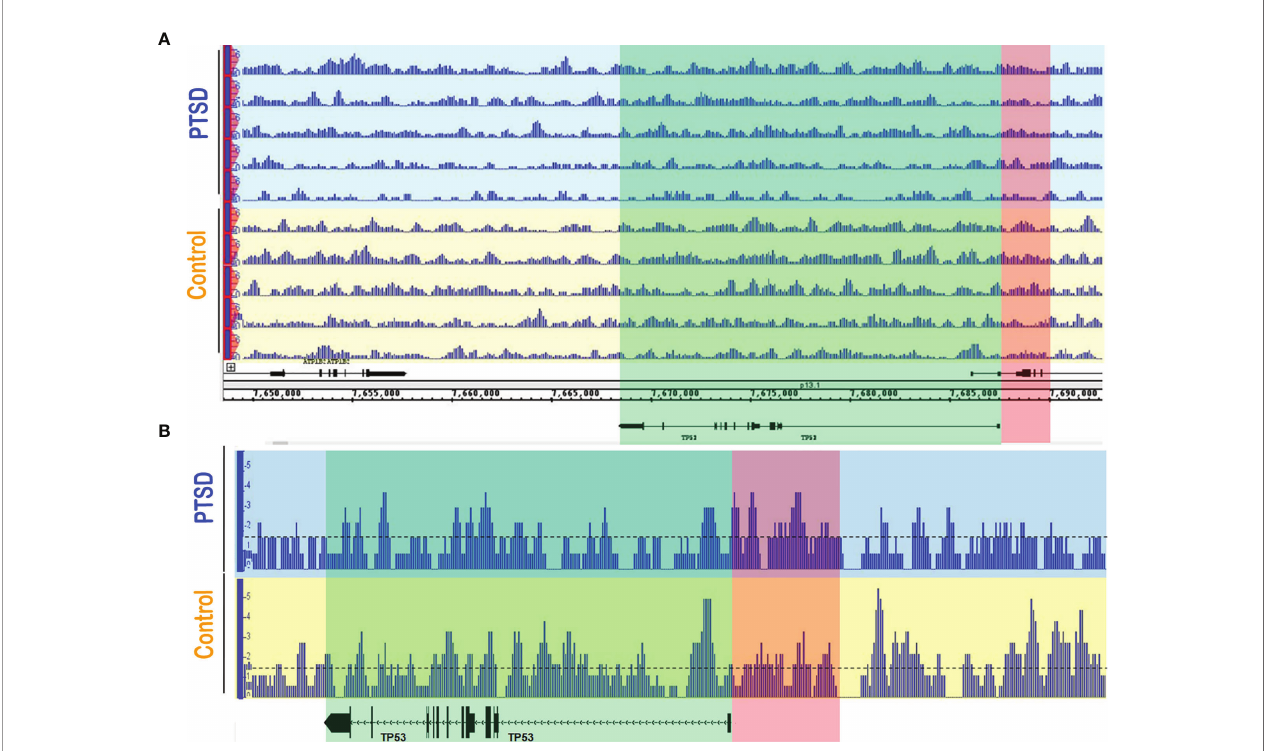
FIGURE 4 | PTSD PBMCs had increased DNA methylation in TP53 promoter region. MeDIP-seq was performed on randomly selected PTSD (n=5) and Control (n=5) PBMC samples. Visualization of the methylated genome was acquired in the IGB genome browser (www.bioviz.org) for (A) individual samples, and (B) combined samples within respective groups. Blue sections indicate PTSD samples, and yellow sections represent Controls. Green section indicates the TP53 gene, while the red section represents one of the known TP53 promoter regions (~5kb) provided in the Ensembl genome browser (www.ensembl.org). For combined data, a line at 1.5 value was drawn to better visualize methylation intensity between the two groups. Differences observed are qualitative measures in which increased signal intensity (e.g. peak height and width) signify more DNA methylation. Signal intensity in the PTSD group was greater overall in the TP53 promoter compared to Control